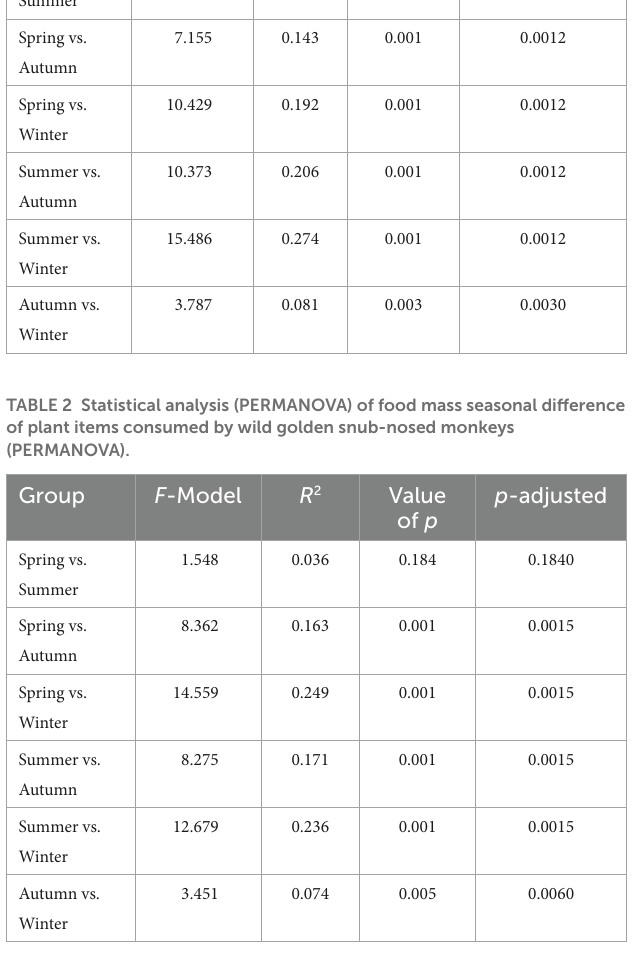
TABLE 1 Statistical analysis (PERMANOVA) of food mass seasonal difference of plant species consumed by wild golden snub-nosed monkeys. Group F -Model R 2 Value of p